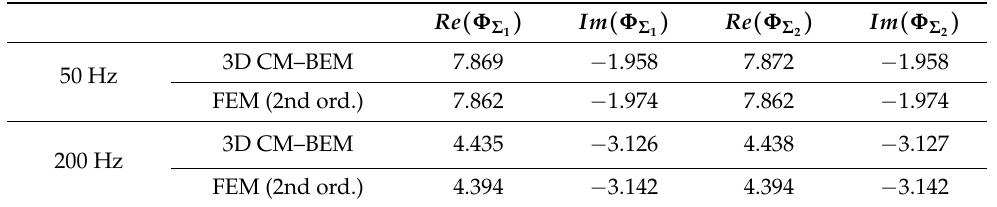
Table 1. Real and imaginary parts of magnetic flux (µWb) computed through cut surfaces Σ 1 , Σ 2 by 3D CM–BEM and 3D FEM (2nd order) at 50 Hz and 200 Hz frequency.